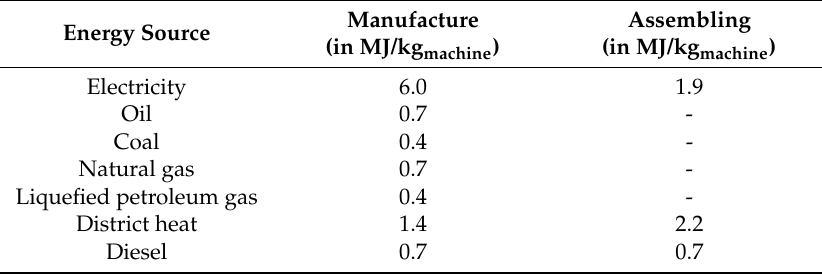
Table 3. Input data regarding energy source for machine manufacture and machine assembling in MJ per kg of machine, adapted from Athanassiadis et al.